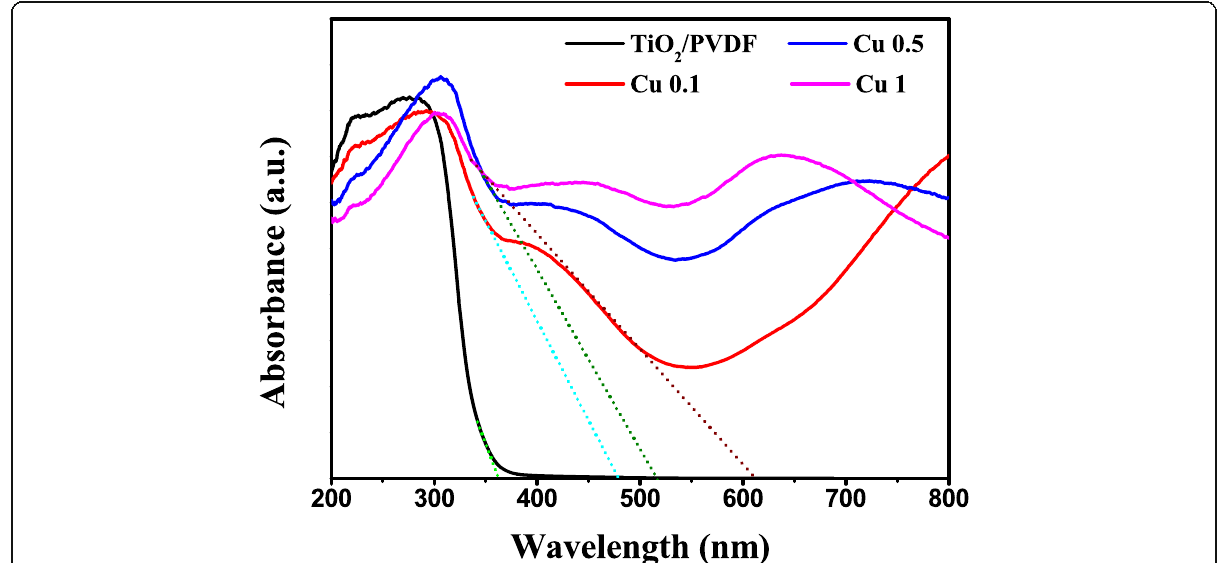
Fig. 5 UV-Vis diffuses reflectance spectra of TiO 2 /PVDF, Cu 0.1, Cu 0.5, and Cu